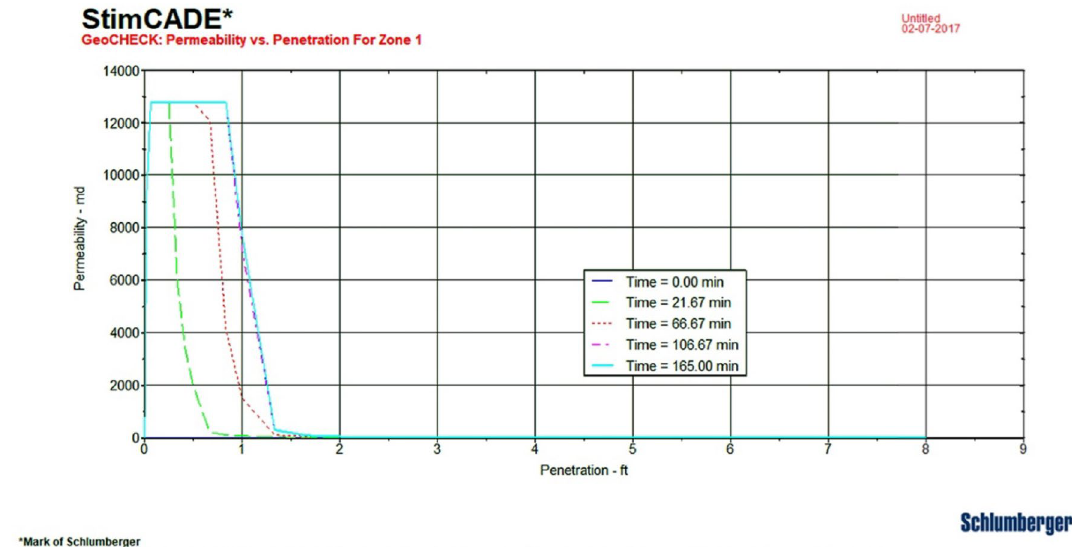
Fig. 8 Permeability changes versus acid penetration